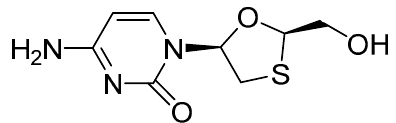
Figure 3. The structure of lamivudine ( 3TC ). Table 2. Inhibitory effect of OA-n on HBsAg and HBeAg secretion in HepG2.2.15 cells. Data are expressed as inhibitory ratio ± SD based on three independent experiments.